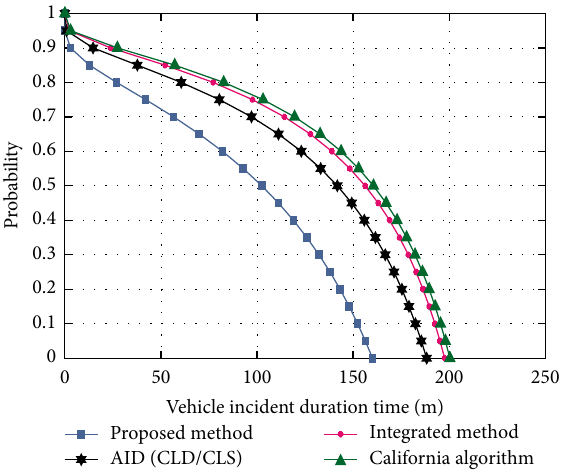
Figure 9: Show the comparisons of the KM curves of the proposed method with other AID